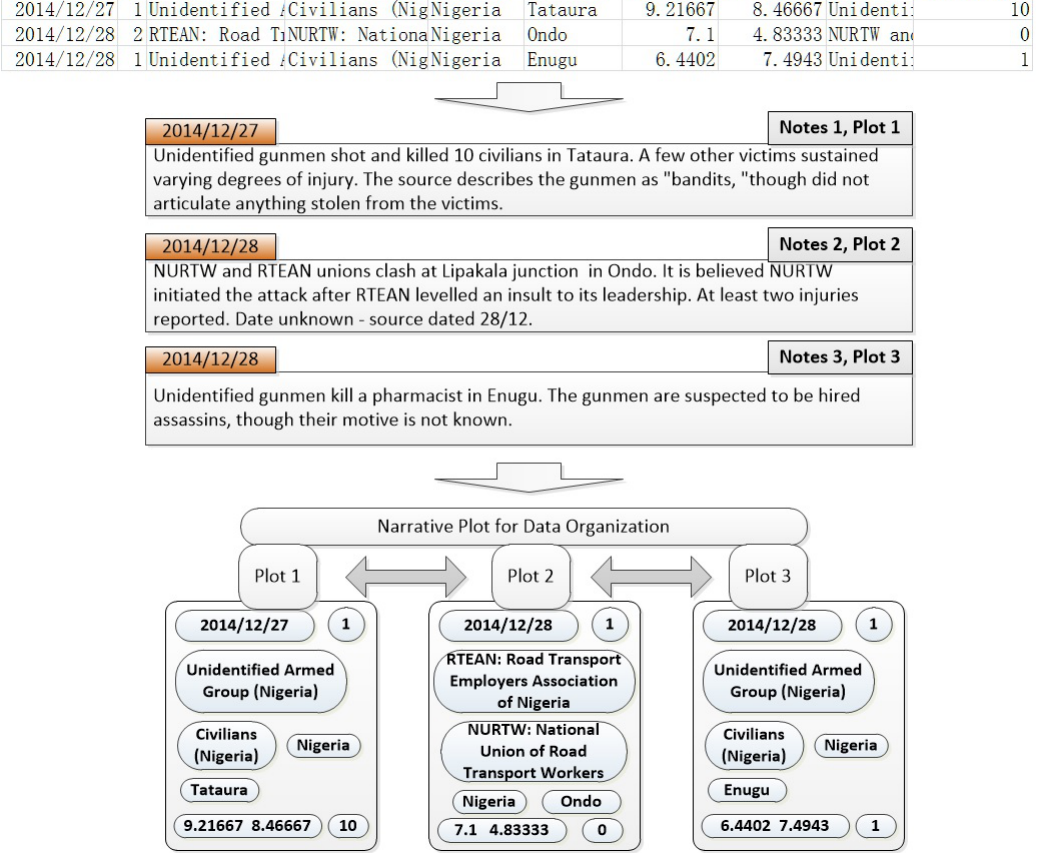
Figure 4. Narrative plot for data